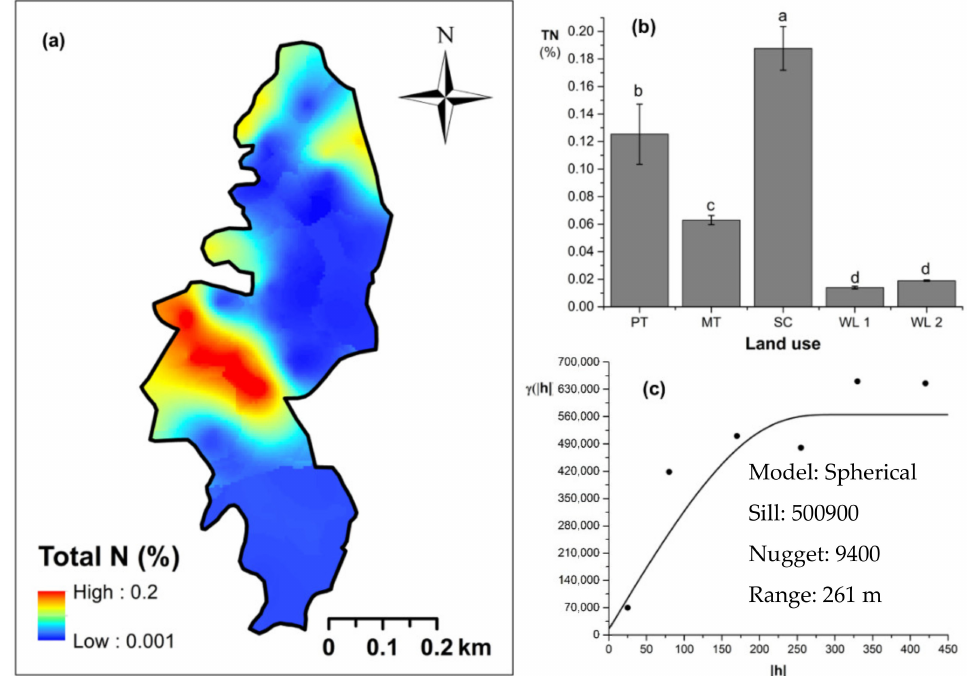
Figure 4. Spatial variability total soil nitrogen (total N): ( a ) map, ( b ) bar graph among different land uses (see Figure 1, label A for notations), and ( c ) variogram between lag distance and semivariance in the Endane Biodiversity Corridor, linking the Iharakanda Proposed Forest Reserve and Sinharaja Rainforest Complex in the Rathnapura District of Sri Lanka. Semivariance function: γ ( h ) = 9400 + 2878.74 h − 0.0141 h 3 . Comparisons depicted by the different letters in the bars in subfigure ( b ) indicate significant pair-wise differences.